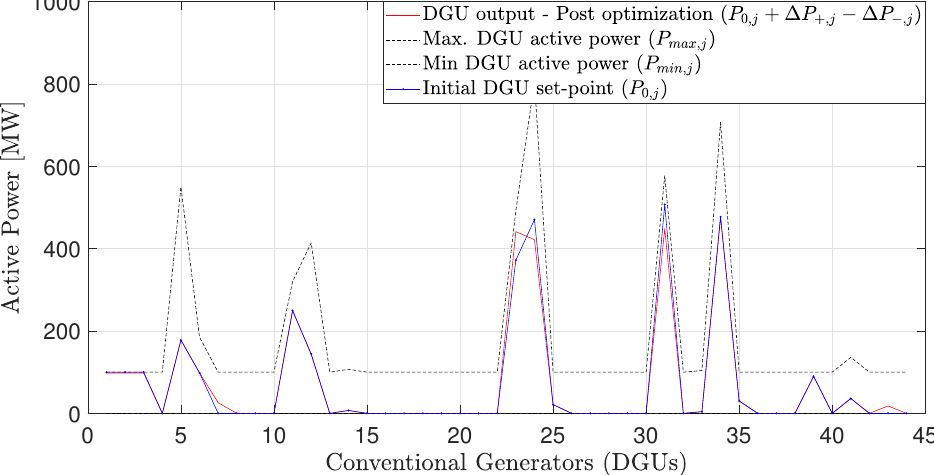
Figure 6. Active power set-points of DGUs after the active power control − Scenario APC2.